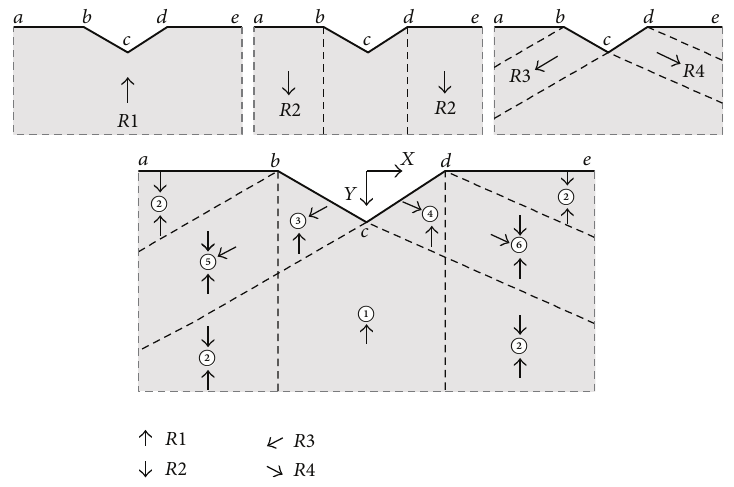
Figure 5: Partition of the domain to compute the free-field. Regions of existence of different rays are identified. 𝑅1 corresponds to the zone illuminated by the main incident front; 𝑅2 is the region of existence of reflection over the horizontal free surface; and 𝑅3 and 𝑅4 correspond to the reflections over the inclined surfaces. Since multiple rays may exist over a given region the total number of rays is described by a number enclosed by circles (bottom part of the